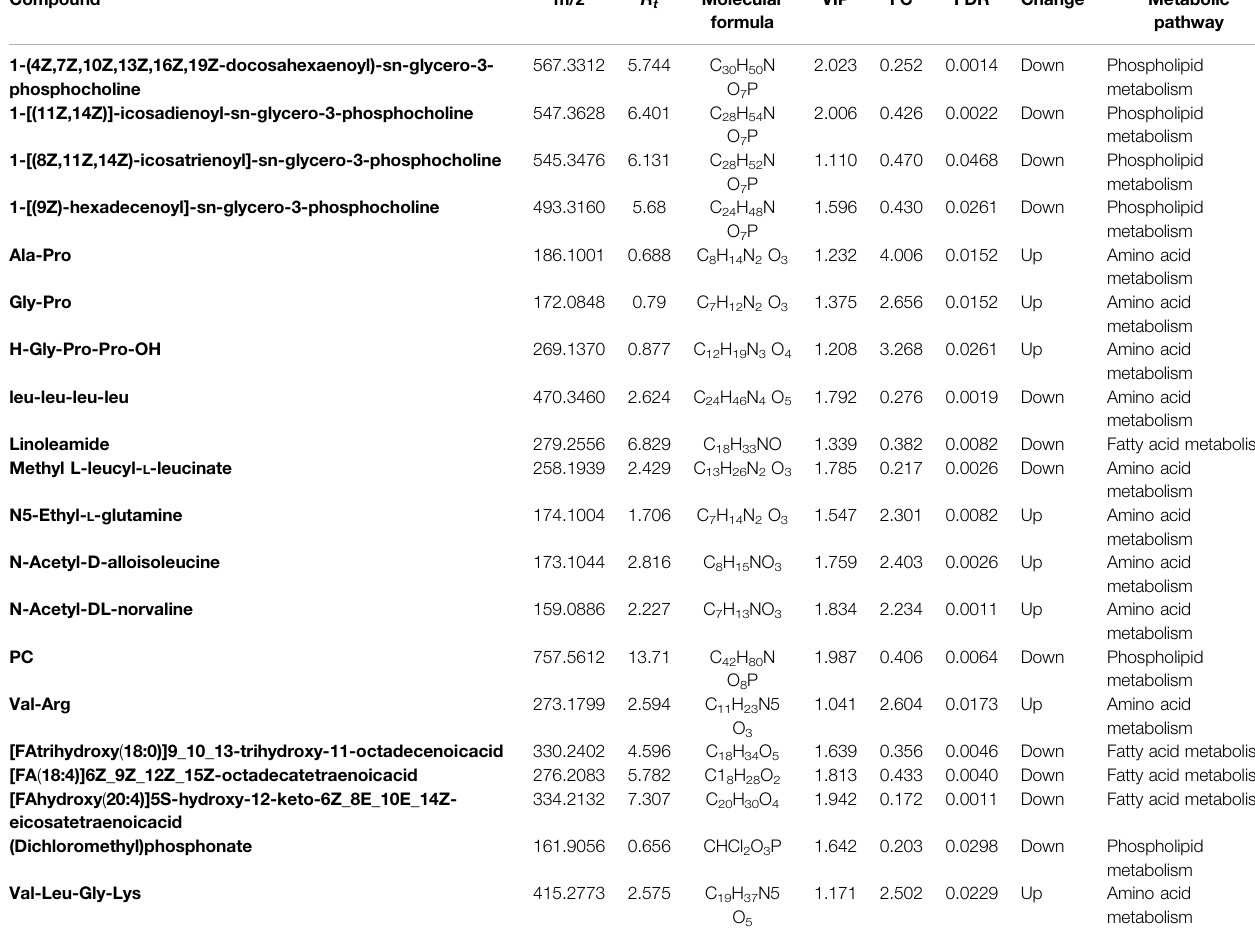
TABLE 2 | The representative differential metabolites identi fi ed in serum samples after base-line treatment.